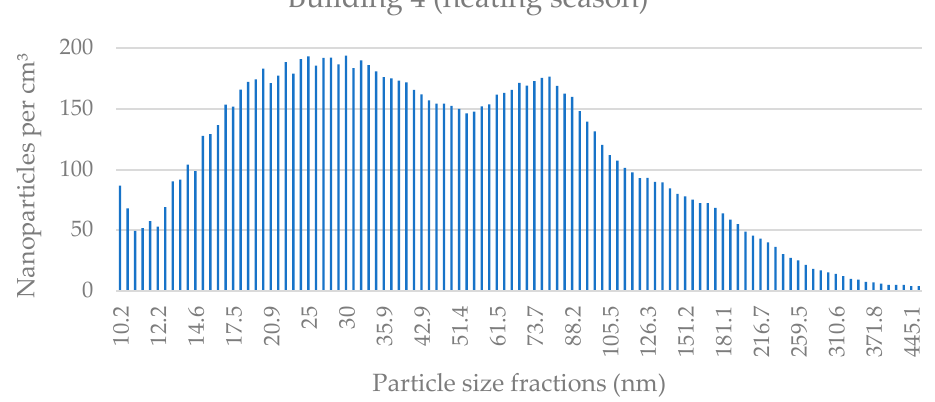
Figure A8. The average nanoparticle concentration in each size fraction in Building 4 during a one- week measurement period during the nonheating season. Figure A9. The average nanoparticle concentration in each size fraction in Building 5 during a one- week measurement period during the heating season.